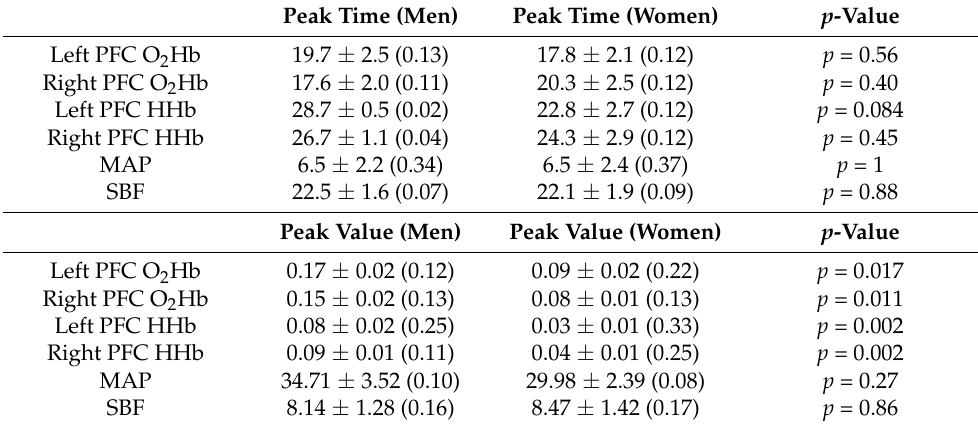
Table 5. Peak time and peak value of each measure during